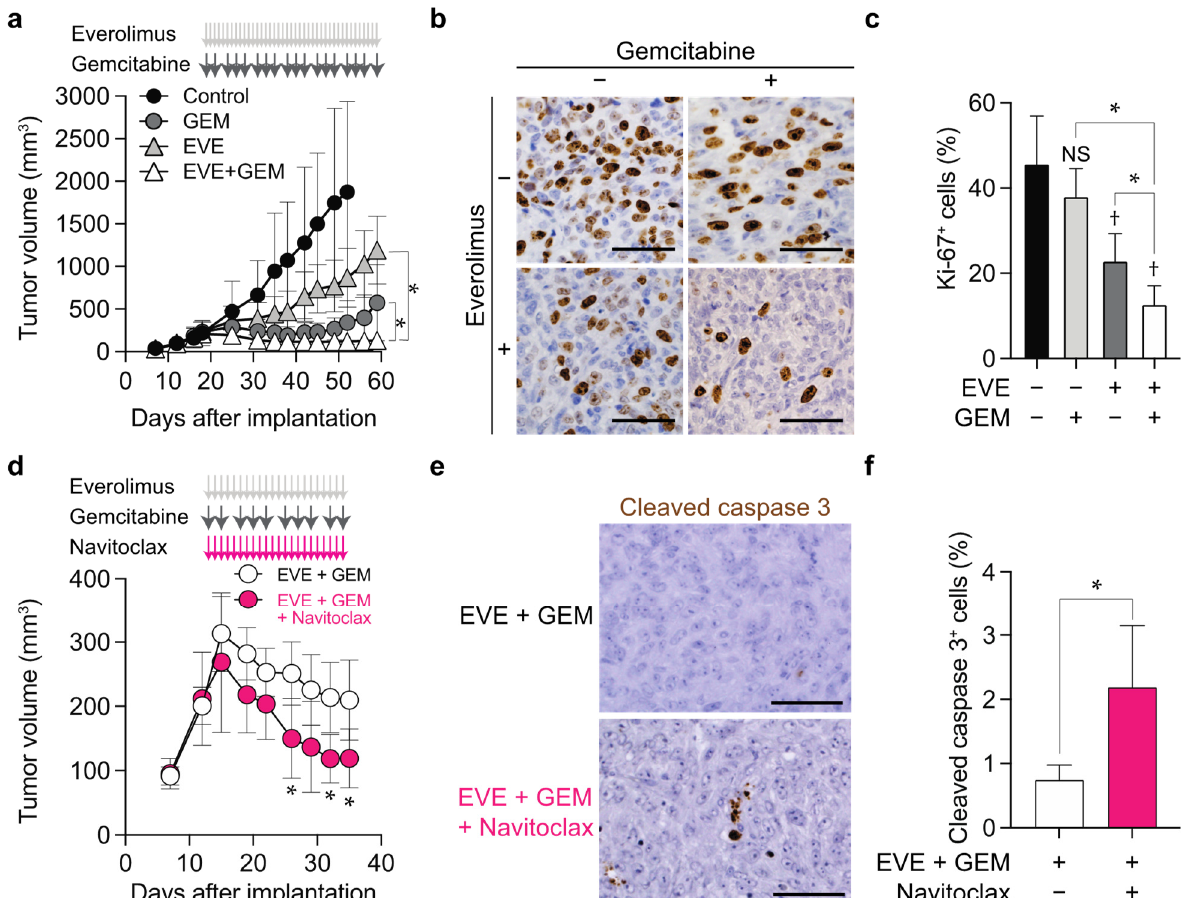
Figure 5. Combined effects of everolimus, gemcitabine, and navitoclax on malignant meningioma cells in vivo. IOMM-Lee cells (1 × 10 6 cells per place) were subcutaneously implanted. After the establishment of tumors had been confirmed, mice were treated with everolimus (2 mg/kg, oral, every day) (EVE), gemcitabine (10 mg/kg, intraperitoneal injection, 3 times a week) (GEM), both (EVE + GEM), or vehicle (Control). The sizes of tumors were measured. n = 8, each group ( a ). Immunohistochemistry for Ki-67 in excised tumors (the Control group on day 53 and the other groups on day 60: one day after the last treatment) ( b ), and the quantification of Ki-67-positive cells ( c ). Alternatively, after the establishment of tumors had been confirmed, mice were treated with everolimus (2 mg/kg, oral, every day) in combination with gemcitabine (10 mg/kg, intraperitoneal injection, 3 times a week) and navitoclax (100 mg/kg, oral, every day) (EVE + GEM + Nav) or vehicle (EVE + GEM). The sizes of tumors were measured. n = 8, each group ( d ). Immunohistochemistry for cleaved caspase 3 in excised tumors (on day 36: one day after the last treatment) ( e ) and the quantification of cleaved caspase-3-positive cells ( f ). Values are shown as the mean ± or + SD. p - values were calculated by a one-way ANOVA with Tukey’s post hoc test ( a , c ), by a two-way ANOVA with Tukey’s post hoc test ( d ), or by the Student’s t -test ( f ). * p < 0.05. NS p ≥ 0.05 and † p < 0.05, vs. the Control (EVE − and GEM − ). Scale bars, 50 µ